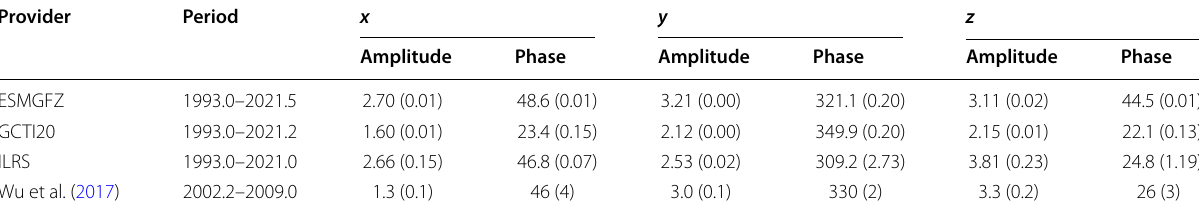
Table 3 Annual amplitudes (in [mm]) and phases (in [d] since January 1st) from a spectrum analysis of the coordinate-wise geocentre motions generated by the combined NTL of ESMGFZ and GCTI20, the ILRS solution, and the unified approach by Wu et al. (2017) (see their Table 1). The corresponding time-series periods are listed in the column ”period”. Formal errors are given in